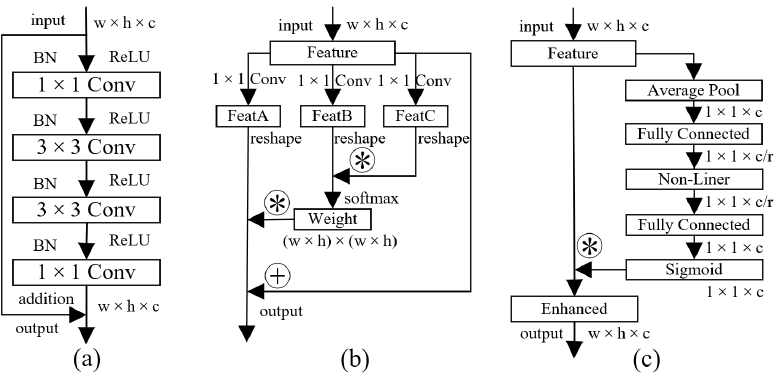
Figure 4. Details of the related blocks. ( a ) The residual block (RB). ( b ) The spatial attention block (SA). ( c ) The channel attention block